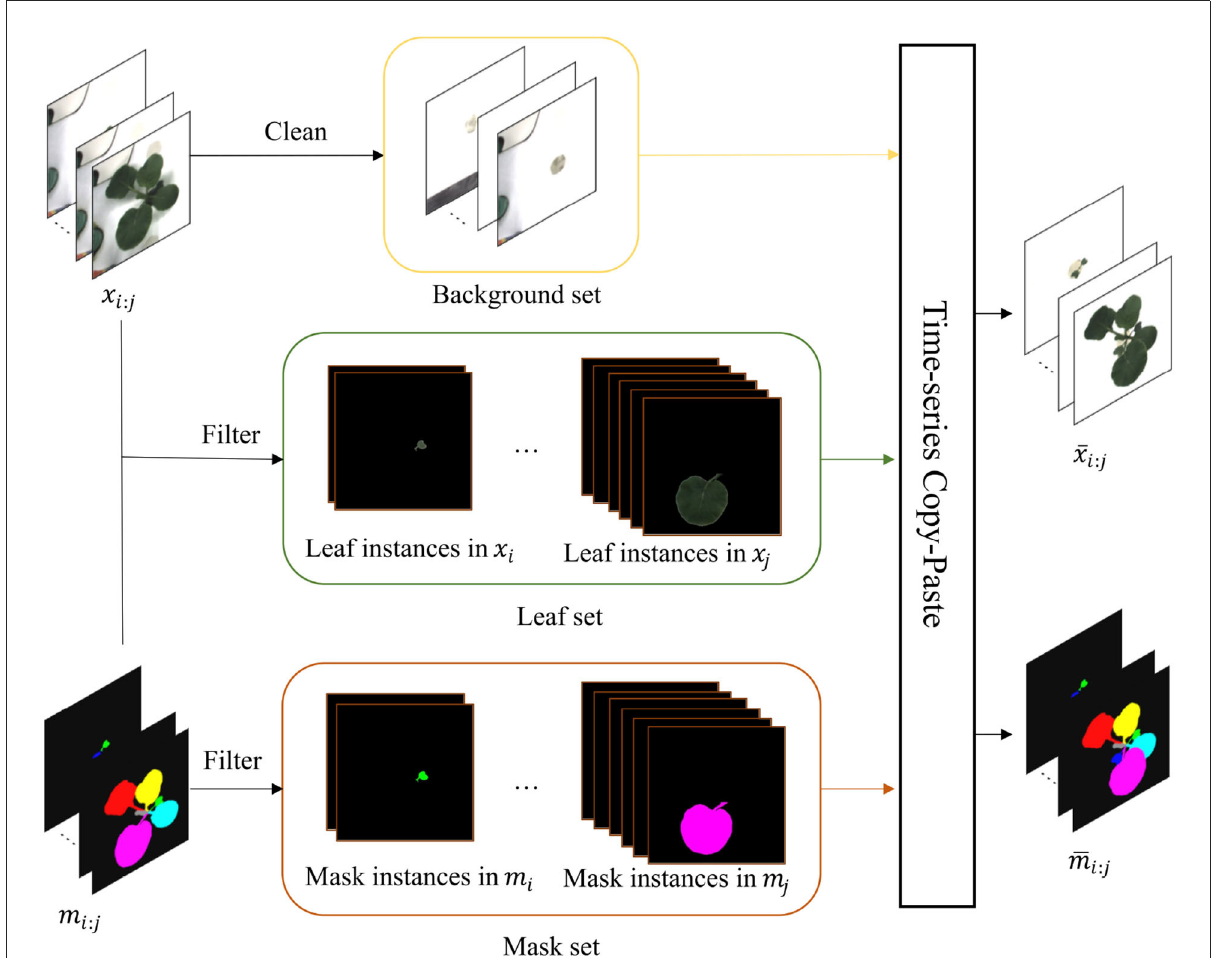
FIGURE4 T-Copy-Paste data augmentation process. It consists of two steps: building up three sets of background, leaf, and mask, respectively from the given original dataset, and generating new RGB image and instance mask sequences by doing copy and paste of element(s) from the three sets sequentially over time. The x i : j and m i : j are the input sequences of RGB images and instance masks, respectively. After obtaining a clean background, suitable leaves, and their corresponding masks, we can generate new time-series images with copy and paste operation. The ¯ x i : j and ¯ m i : j denote generated new RGB image and instance mask sequences, respectively. Here, leaf-based data augmentation techniques can be applied together.